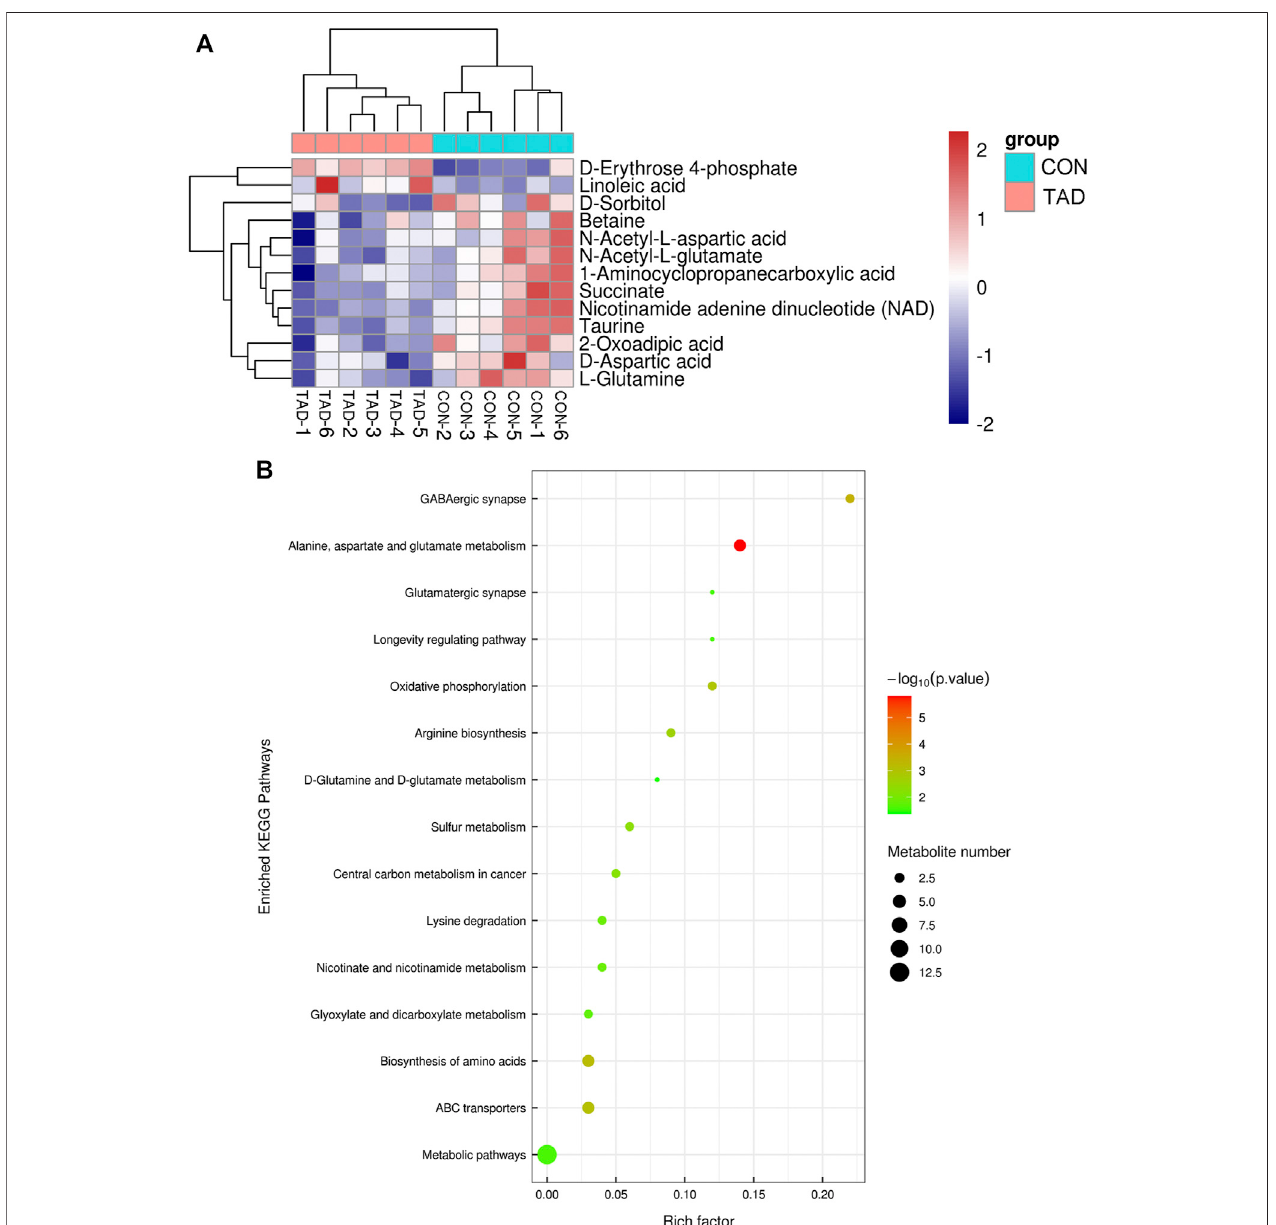
FIGURE 6 | Functional enrichment analysis of DAMs. (A) Heatmap of KEGG pathways. (B) Bubble chart of the KEGG pathways (top 15) that DAMs signi fi cantly involved in. The rich factor is de fi ned as the ratio of the number of DEGs to the total number of genes enriched in a speci fi c category. The count of DEGs was roughly represented by the size of circles. Log10-adjusted p value was indicated by the color saturation from green to red.